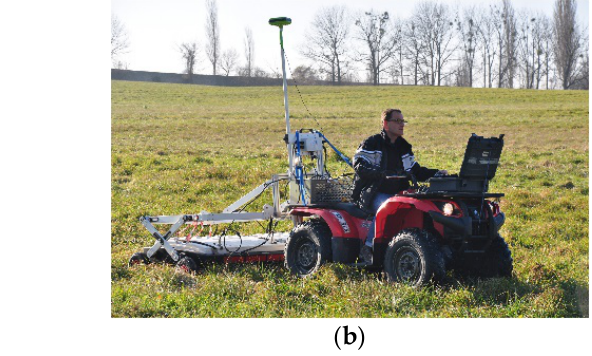
Figure 6. Example of state-of-the-art GPR equipment for precision agriculture. ( a ) Vehicle mounted air-launched GPR array. ( b ) Vehicle mounted ground-coupled GPR array.